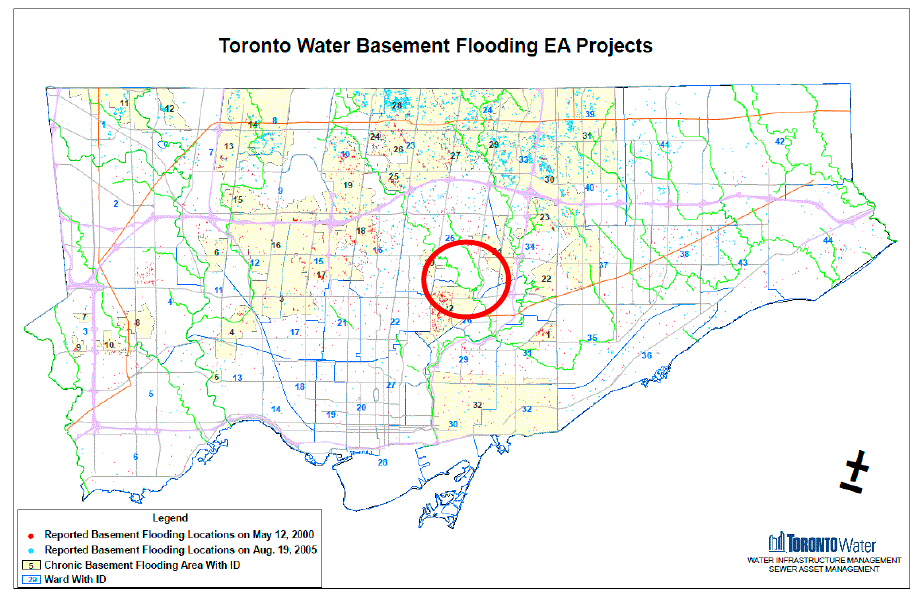
Figure 10. Water basement flooding in Greater Toronto Area in 2000 and 2005. Source: http://www.cityfloodmap.com/2014/07/toronto-flood-map.html.